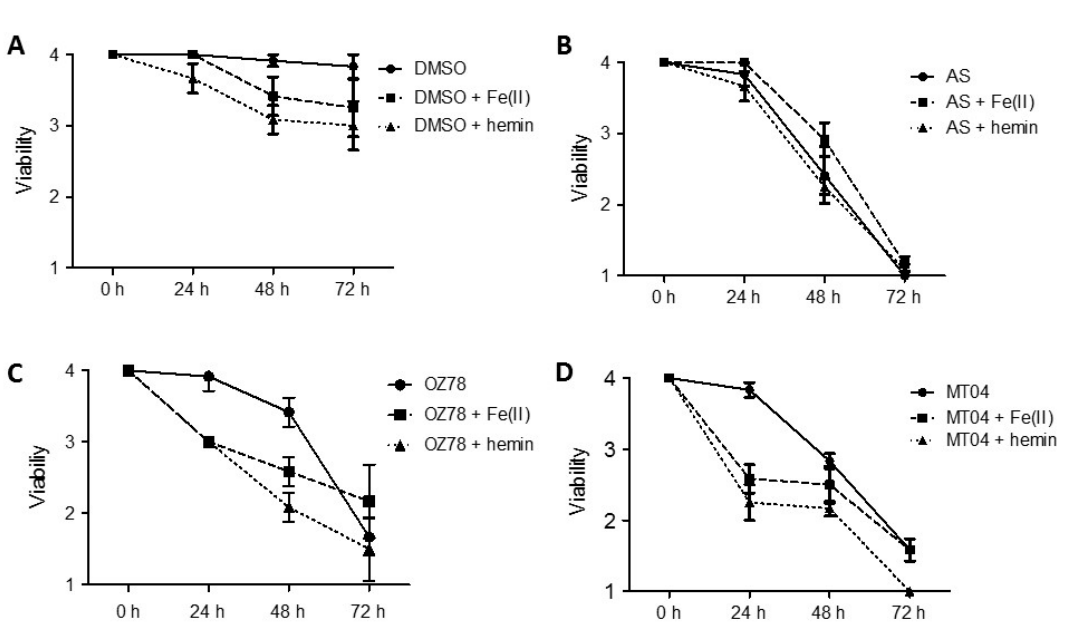
Figure 2. In vitro activity of artesunate (AS), OZ78, and MT04. Adult F. hepatica were obtained from bovine livers. Fasciocidal activity was investigated for AS ( B ), OZ78 ( C ), and MT04 ( D ) at a concentration of 50 µg/mL alone (black line) or in combination with Fe 2+ (dashed line) or hemin (dotted line) and compared to control worms treated with DMSO 1% ( A ). The limits of the whiskers correspond to the standard error of the mean values per time point, n = 6.